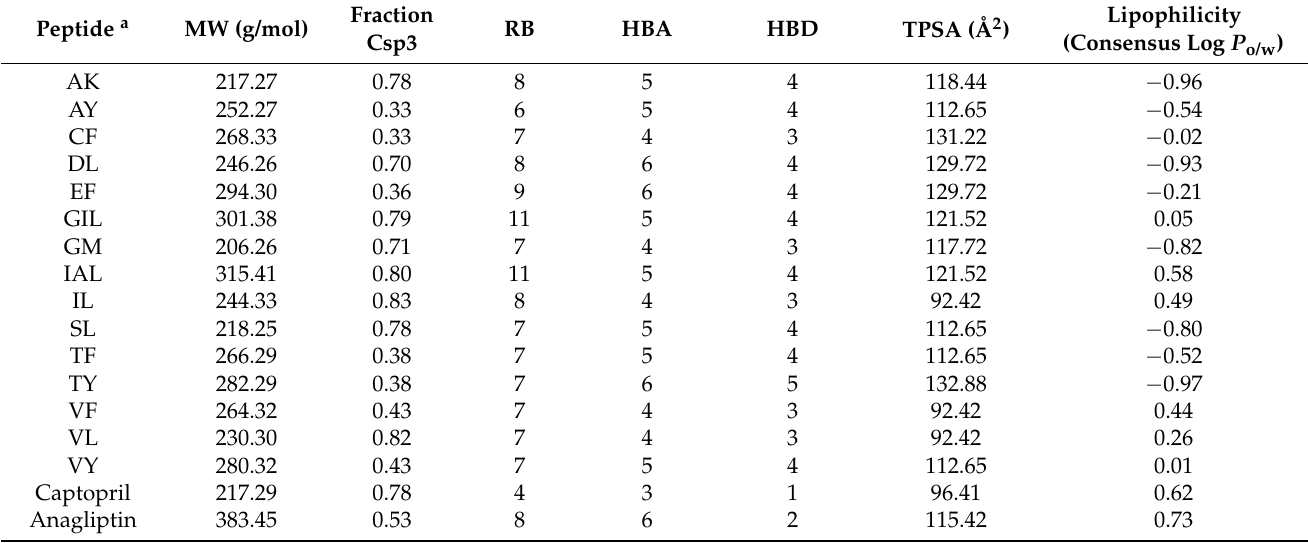
Table 7. Physicochemical properties of peptides having known and potential